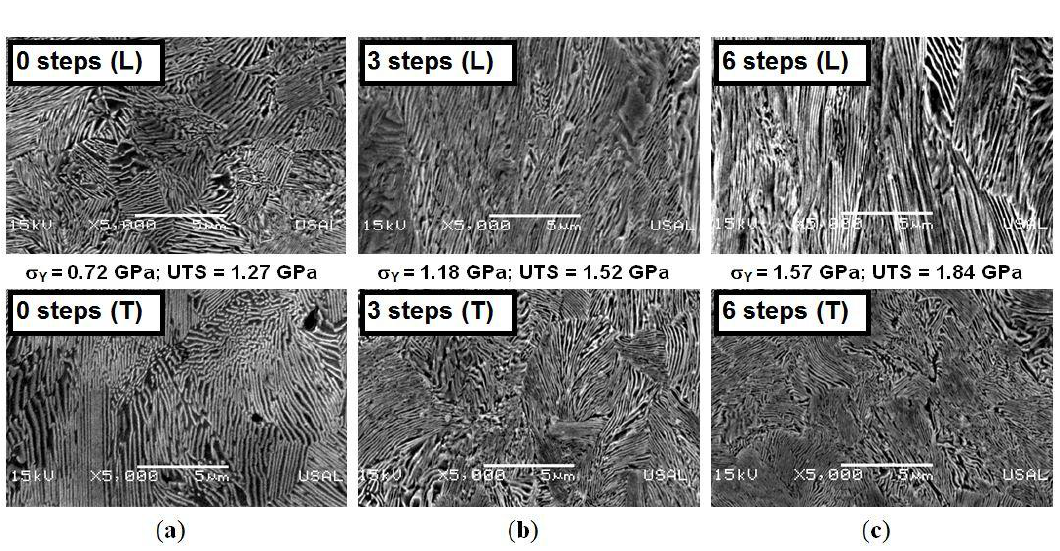
Figure 1. Micrographs of longitudinal (L) and transverse (T) sections of steels at different levels of cold drawing: ( a ) 0 steps, hot rolled bar; ( b ) 3 steps; ( c ) 6 steps, prestressing steel.